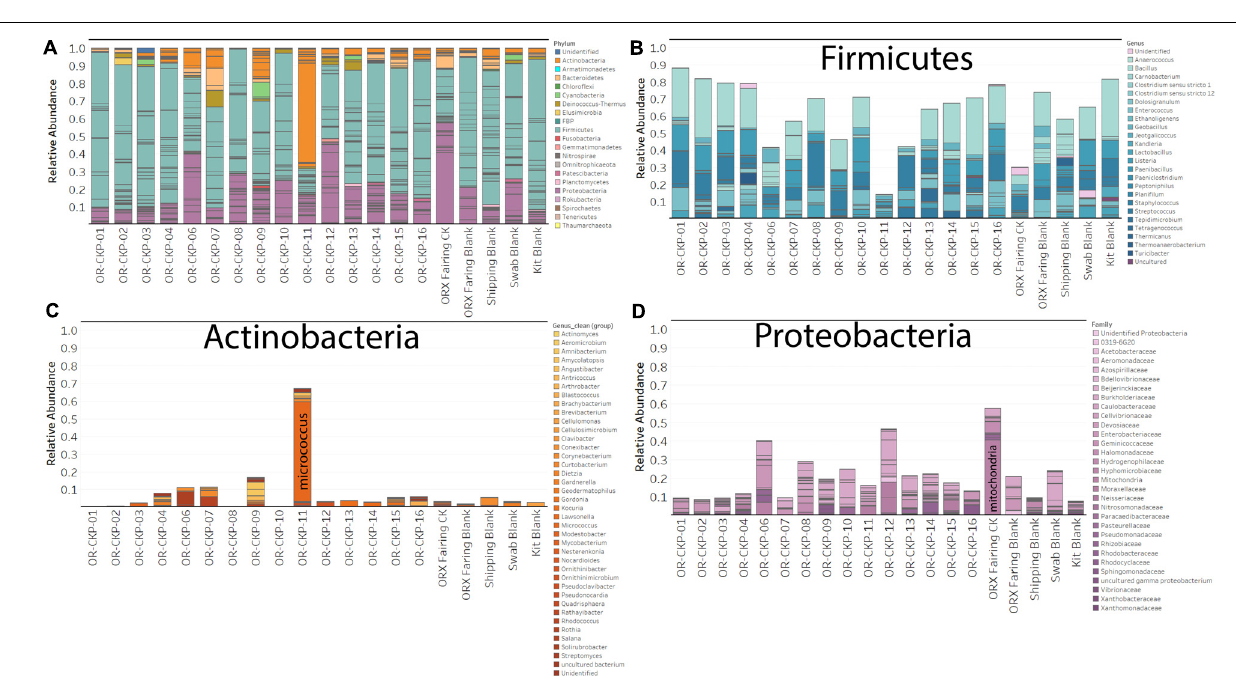
container was being installed. In general, the samples collected after thermal vacuum testing (OR-CKP-11-1-A,0) appear to have more fungal OTUs than those collected prior to this